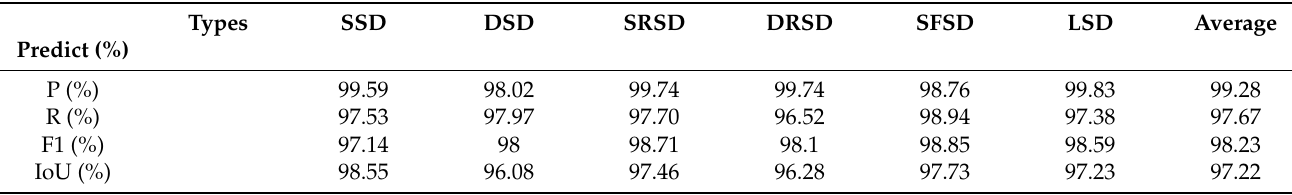
Table 2. Extraction outcome quantitative